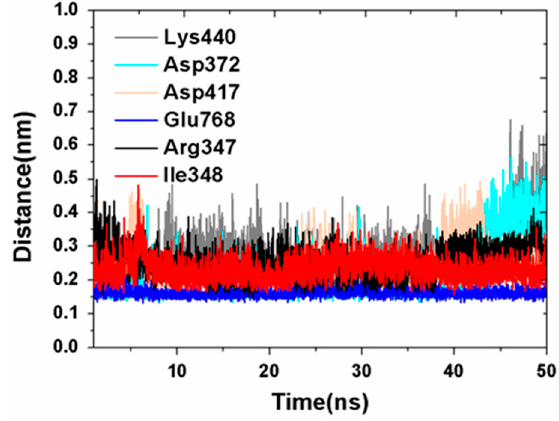
Figure 8. The distances between predicted residues of NanA and chlorogenic acid during 50 ns simulation.